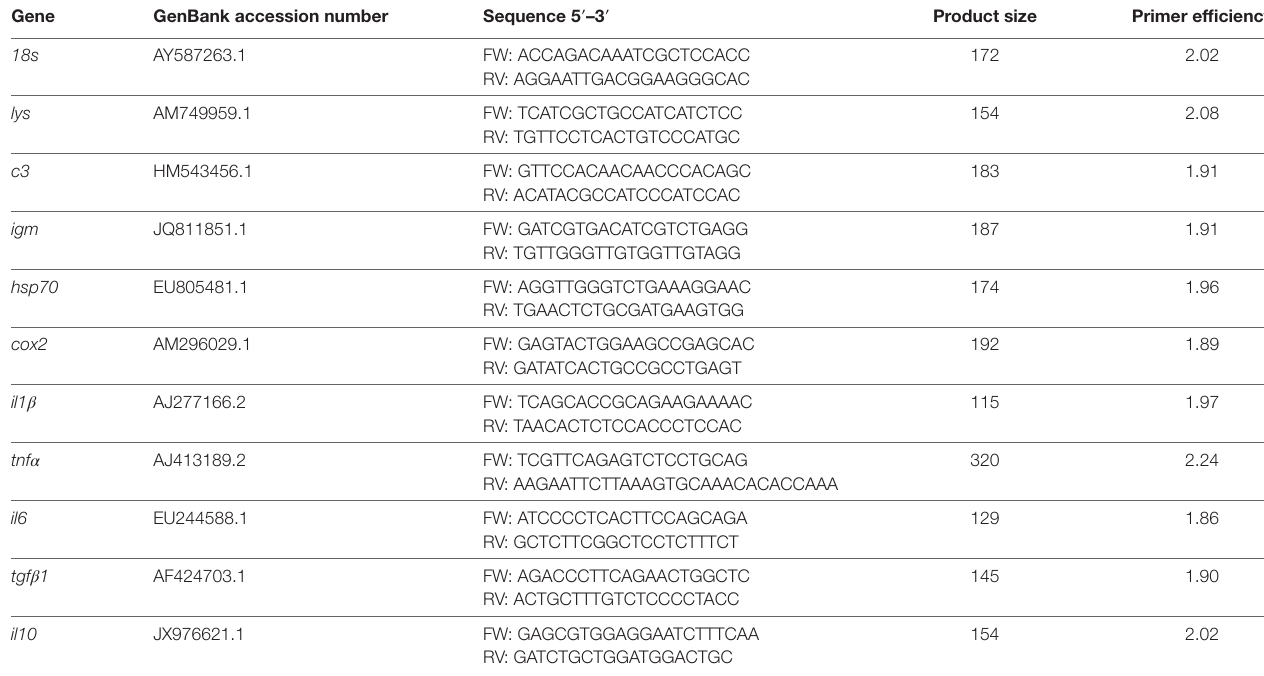
TaBle 2 | Primers used for gene expression analysis in gilthead seabream.